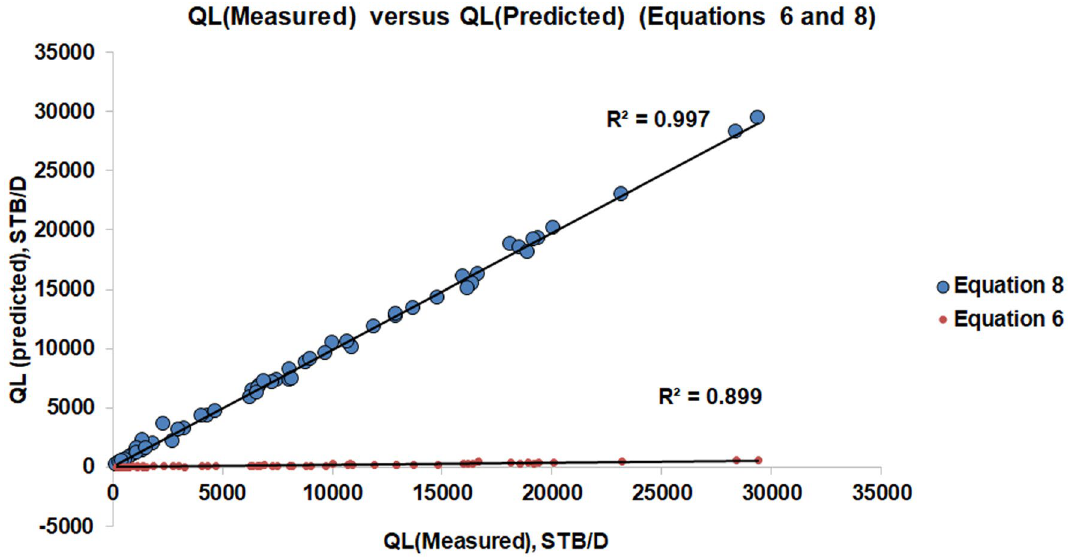
Fig. 7 Liquid flow rate Q Q L(predicted) versus L(measured) reveals a strong correlation for the Reshadat oil field applying Eq. (6) and the GA optimized Eq. (6) to the test data subset (55 data records). However, Eq. (6) provides highly unreliable and inaccurate predictions in comparison to Eq.